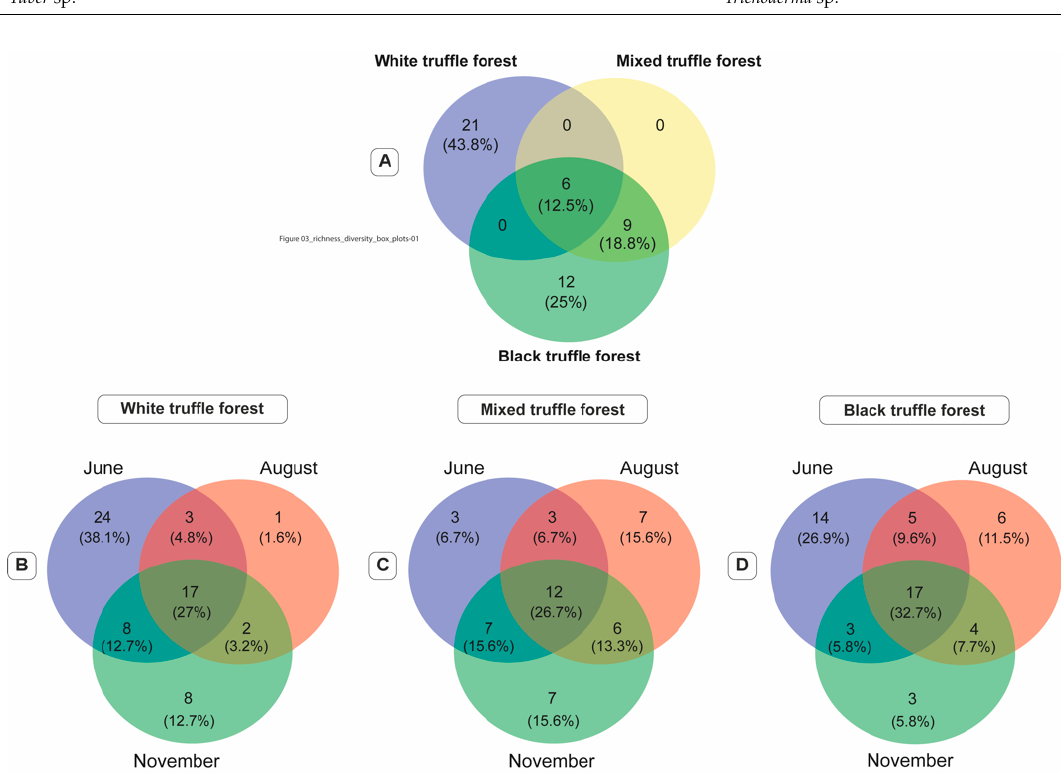
Figure 5. Venn diagrams illustrating shared and specific core fungal genera (defined as genera detected in 95% of the samples of specific forest types) in white, mixed, and black truffle-producing forests ( A ) and within each truffle-producing forest type, across three different sampling time-points (June, August, and November, ( B – D ), respectively). The numbers and percentage values in each Venn diagram represents the number of fungal genera and their percent distributions respective forest type ( A ) or sampling months ( B – D ). Table 4. Core fungal genera (defined as taxa present in 95% samples of the specific forest type) associated with white, black, and mixed truffle-producing forests and their collective percent share of the sequences from the total sequences belonging to a specific group. Black Truffle-Producing Mixed Truffle-Producing White Truffle-Producing Forest Ascochyta sp. Forest Forest